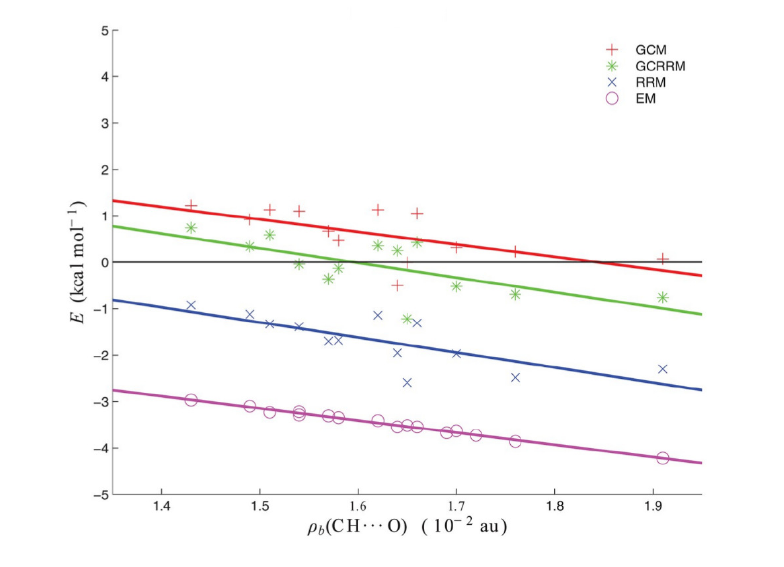
Figure 14. Interaction energies (in kcal/mol) of the intramolecular C-H · · · O contacts in the molecules investigated in ref.